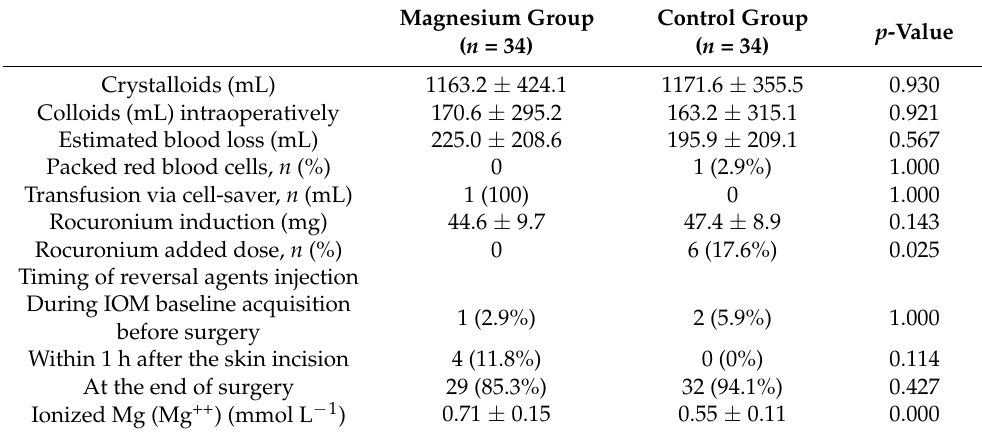
Table 4. Intraoperative anesthesia related variables.